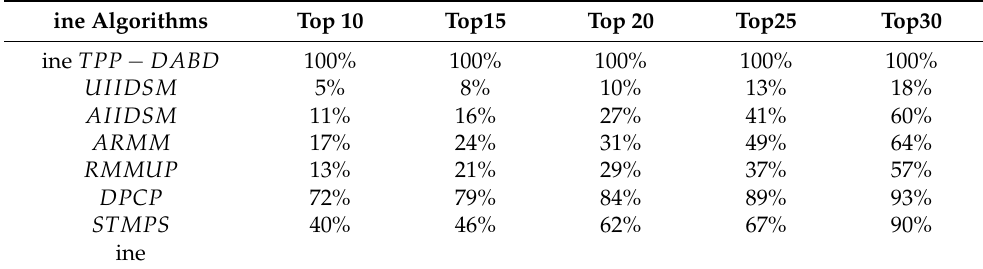
Table 7. The SFRR of trajectory privacy-preserving